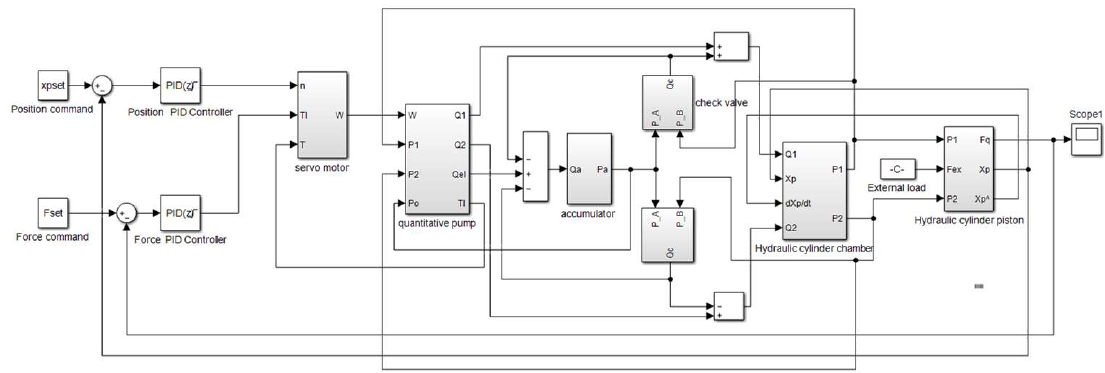
Figure 15. The whole system simulation model.